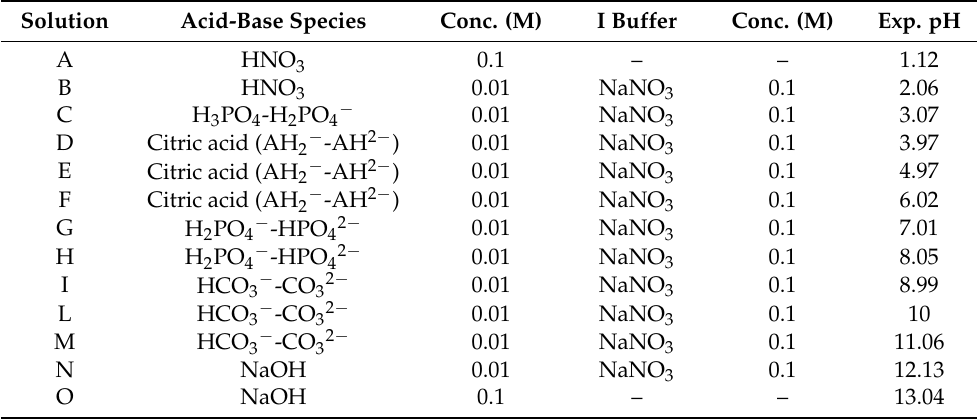
Table 2. Solutions used for the training samples (A–O).